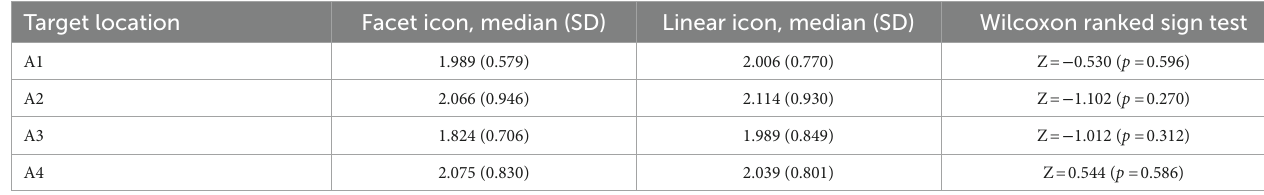
TABLE 3 Results of the fixation duration along the different locations.